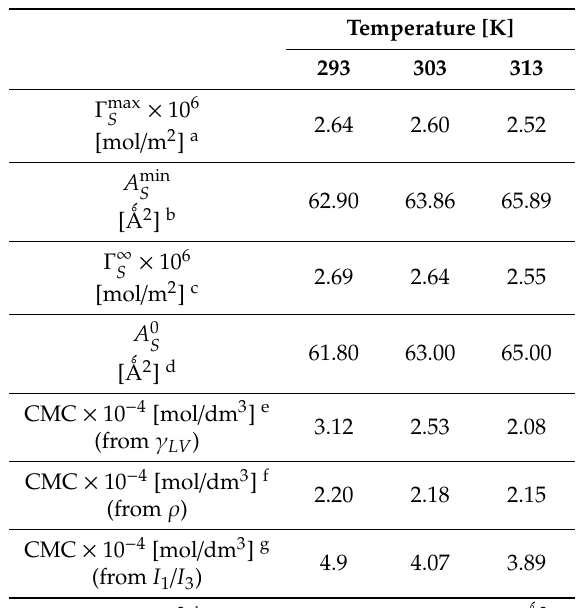
Table 1. The values of maximal Gibbs surface excess concentration ( Γ max molecules at the water-air interface ( A min area ( A 0 ), critical micelle concentration (CMC) at 293 K, 303 K and 313 K. S